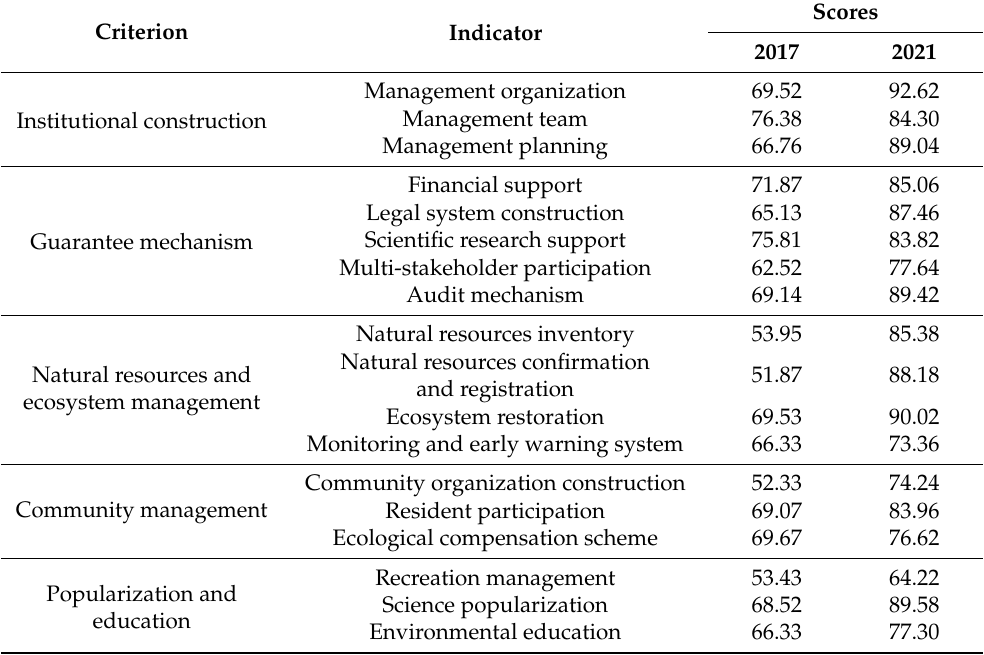
Table 5. Scores of single management capacity of TNP in 2017 and